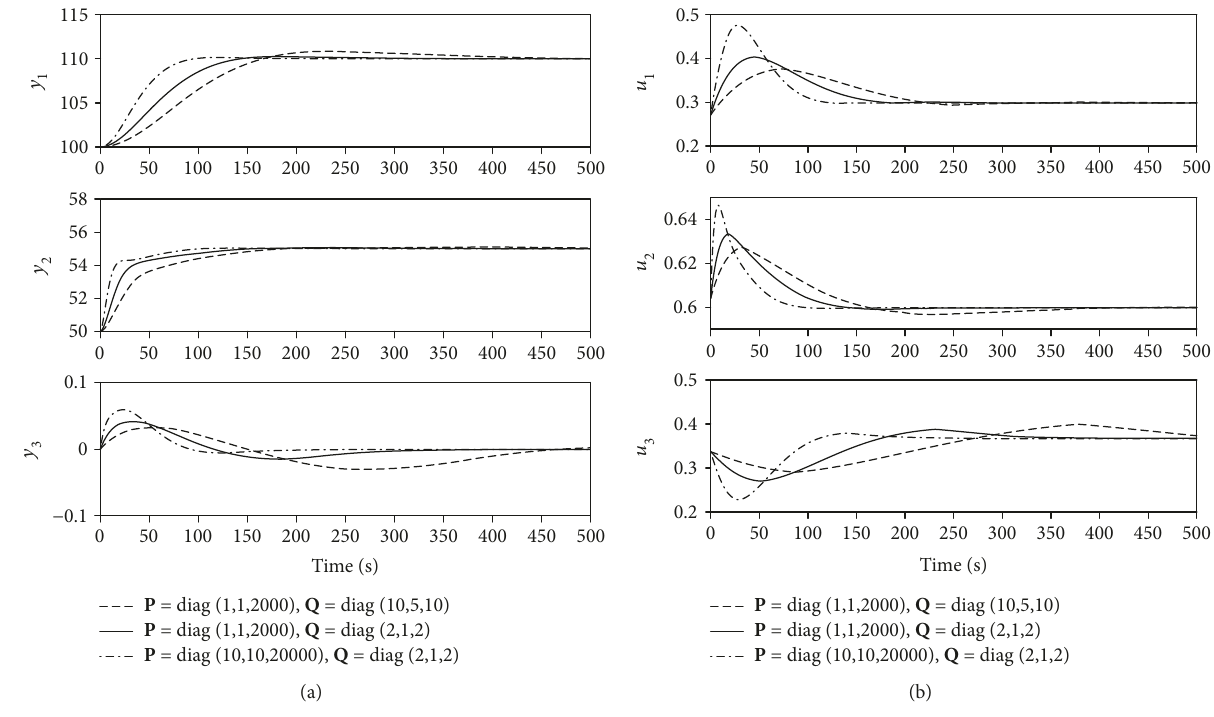
Figure 7: Outputs and controls of the unit when taking di ff erent values of P and Q